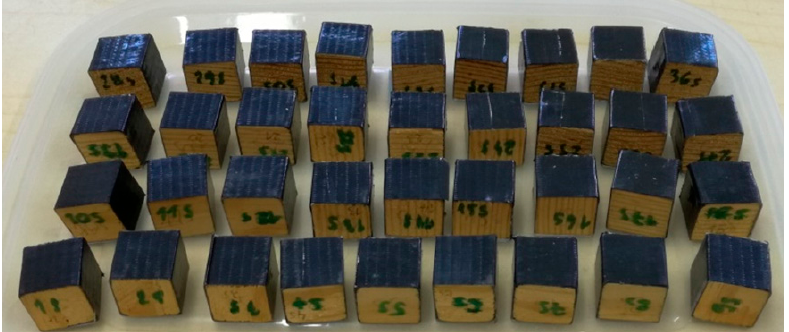
anatomical directions: radial, tangential and longitudinal (Figure 5) and weighed again to calculate the mass of insulation used.